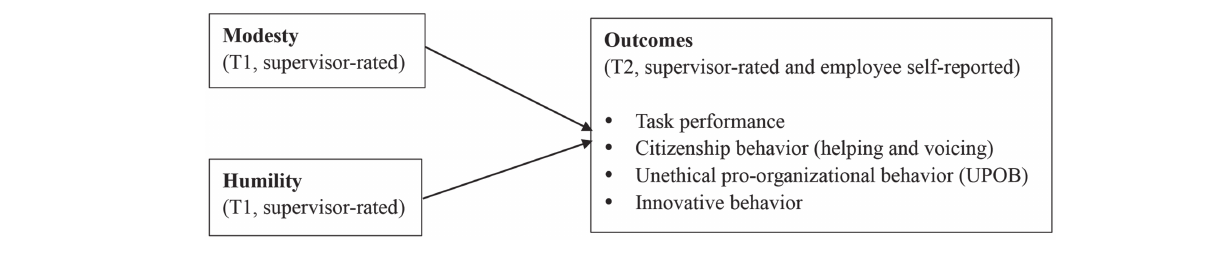
FIGURE 1 | Research